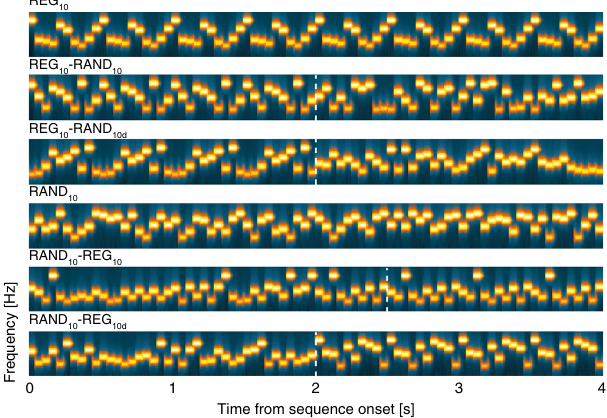
Fig. 4 Example spectrograms for the additional stimuli used in Experiment 2. REG 10 and RAND 10 were generated by randomly selecting 10 frequencies from the pool and then either iterating that sequence to create a regularly repeating pattern or presenting them in random order. REG 10 -RAND 10 and RAND 10 -REG 10 sequences were created from the same 10 frequencies (different sets on each trial). Thus, the transition was manifested as a change in pattern only, without the occurrence of a frequency deviant. REG 10 -RAND 10d and RAND 10 -REG 10d were created such that the frequencies used for the REG and RAND portions of the sequence were different (non-overlapping sets of 10 frequencies each). The transition was thus manifested as both a change in pattern, and also as a change in frequency content. The stimulus set also included REG 10 -RAND 20 , RAND 20 -REG 10 and RAND 20 sequences (identical to those in Experiment 1). Dashed vertical white lines indicate the transition time. Note that for RAND 10 -REG 10 the transition time is de fi ned as occurring after the fi rst full regularity cycle (see also Fig. 1). The transition time is not adjusted for RAND 10 -REG 10d because the transition becomes statistically detectable immediately when the alphabet changes (at the nominal transition time). For presentation purposes, the plotted sequence lengths are equal, but experimental sequences durations varied randomly between 6.0 and 7.5